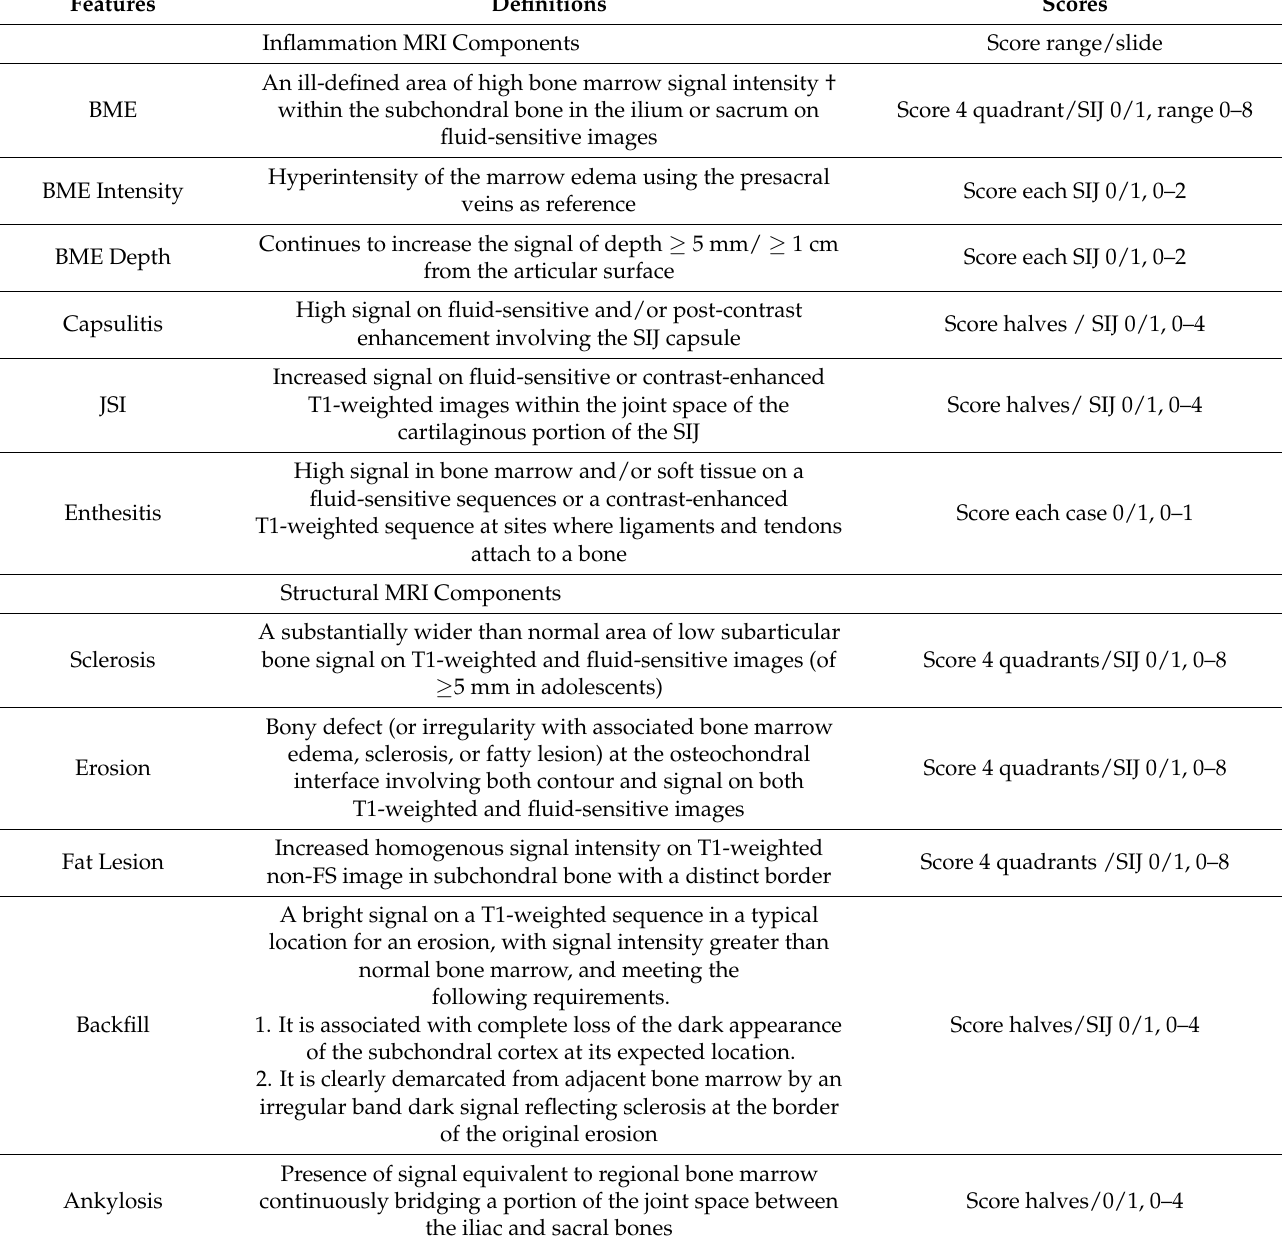
Table 1. Features and definitions of inflammation and structural components of an MRI scoring system for sacroiliac joints.